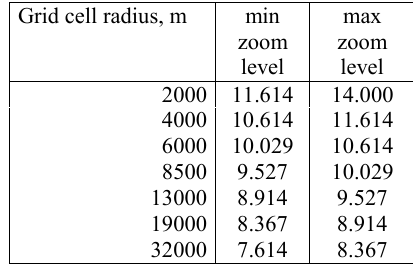
Table 1 . Zoom levels for each layer of hexagonal grid calculated by developed